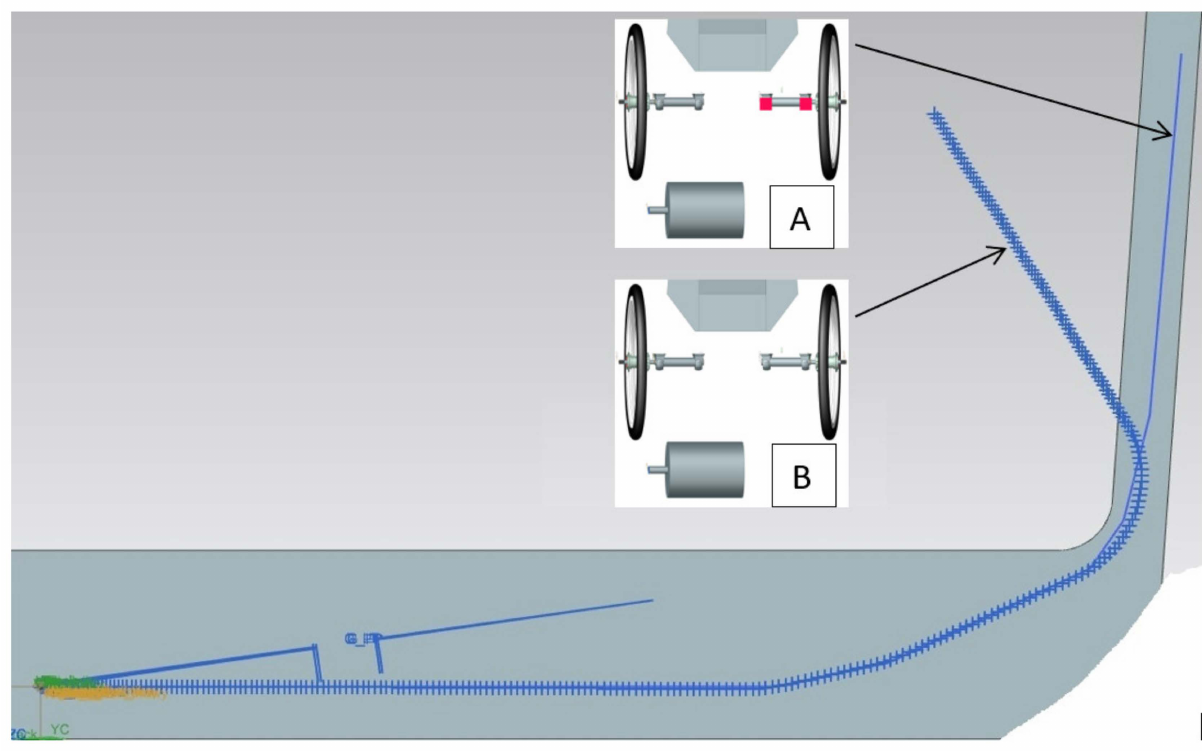
Figure 8. Comparison of the track of the car without (thick line) and with the elastic bushing (thin line). Significant differences in vehicle trajectory were observed. The thin line implies the racing line of the car with the elastic suspension. It can be seen that adding an elastic bushing on the outer side of the car results in a wider turning